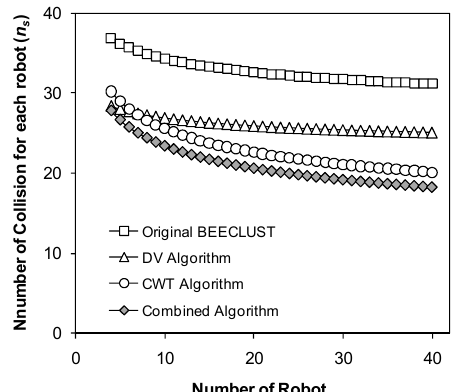
Fig. 15. Estimation of collision number for a single robot as a function population size